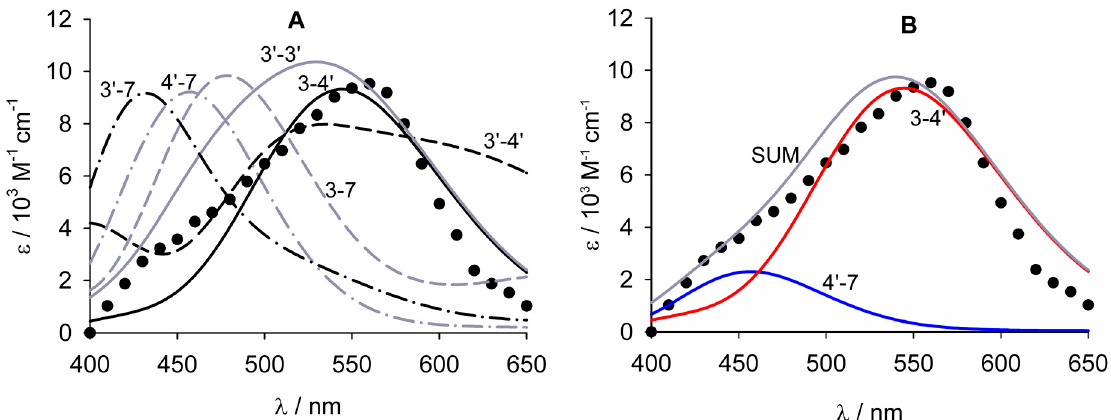
Figure 5. ( A ) Calculated UV–vis spectra of the radical anions of quercetin in water, compared to the experimental spectrum measured at pH 5.8 ( ● ) by Jovanovich et al. [38]. The spectra for the tautomers involving the 5–OH are omitted for clarity. ( B ) Simulation of the spectrum arising from the overlay of radical anions in positions 3 ‐ 4 ′ and 4 ′‐ 7 in relative ratio 3.2:1 (SUM). Numbers indicate the position of the radical and of the negative charge.